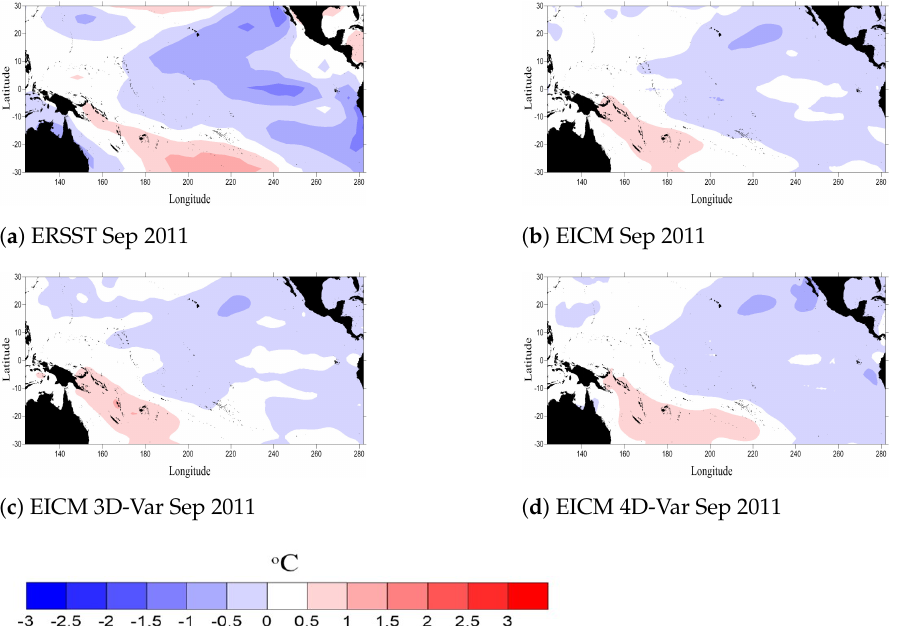
Figure 6. Pacific region SSTA values ( ◦ C) in September 2011 from ERSST measurements ( a ), and the SSTA prediction results at 1-month lead time of EICM ( b ), EICM 3D-Var ( c ), and EICM 4D-Var ( d